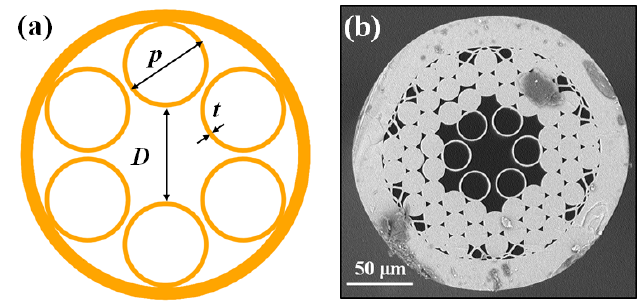
Figure 1. ( a ) Schematic diagram of the cross-sectional view of a negative curvature HC-ARF (Hollow-Core Anti-Resonant Fiber). t is the capillary wall thickness; p is the capillary outer diameter; and D is the core diameter. ( b ) HC-ARF fabricated by the stack and draw method that produces a good